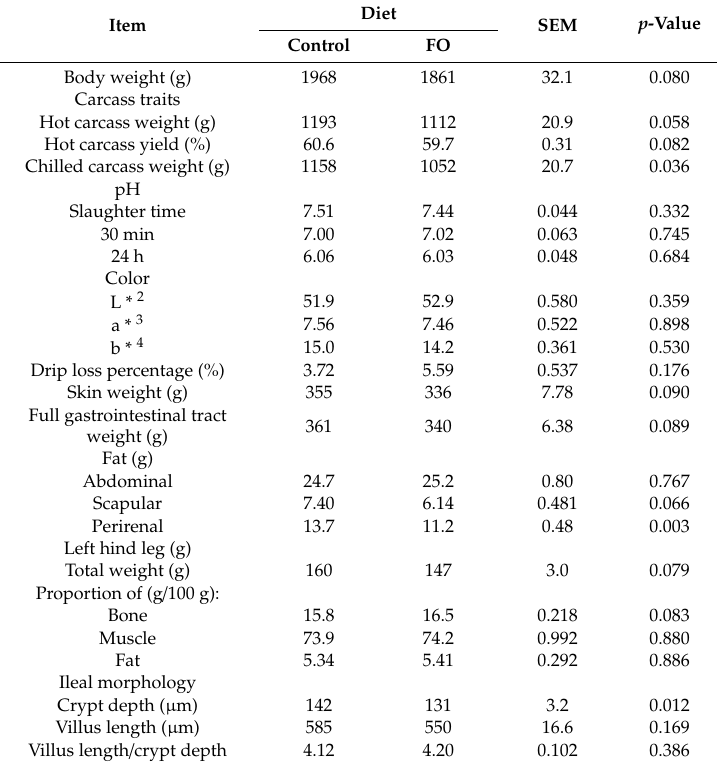
Table 3. Live body weight at slaughter, carcass traits, tissue composition of the left hind leg, and ileal morphology of growing rabbits fed diets with either lard (control) or fish oil (FO) as the fat source and slaughtered at 60 days of age 1 .